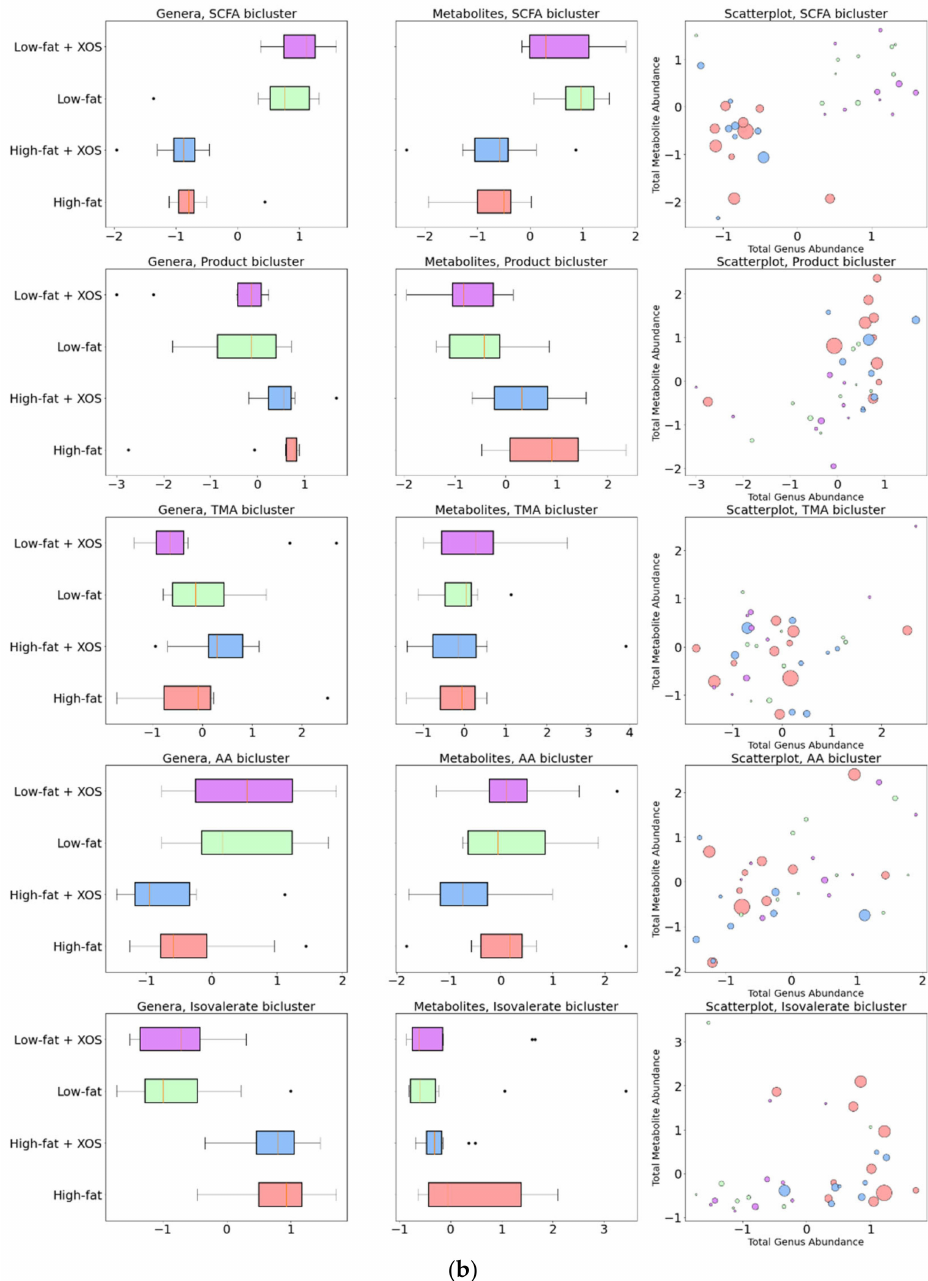
Figure 1. Biclustering results: ( a ) Heat map of Spearman correlation coefficients between the metabo- lites and genera. The color of a node indicates the magnitude and the direction of correlation. Biclusters suggested by the spectral co-clustering algorithm are visible as the diagonal highlighted blocks. The resulting checkerboard structure is a side product of the algorithm and allows the obser- vation of cross-cluster associations such as the congregated negative correlations in the upper-right corner. ( b ) Summed relative genus and absolute metabolite abundances in each bicluster. Boxes indicate quartiles; points outside whiskers are outliers. Scatter markers were sized to indicate hepatic fat (triglycerides) in each sample. Bacterial relative abundances were summed and then centered log ratio (clr) -transformed. Both axes were mean centered at